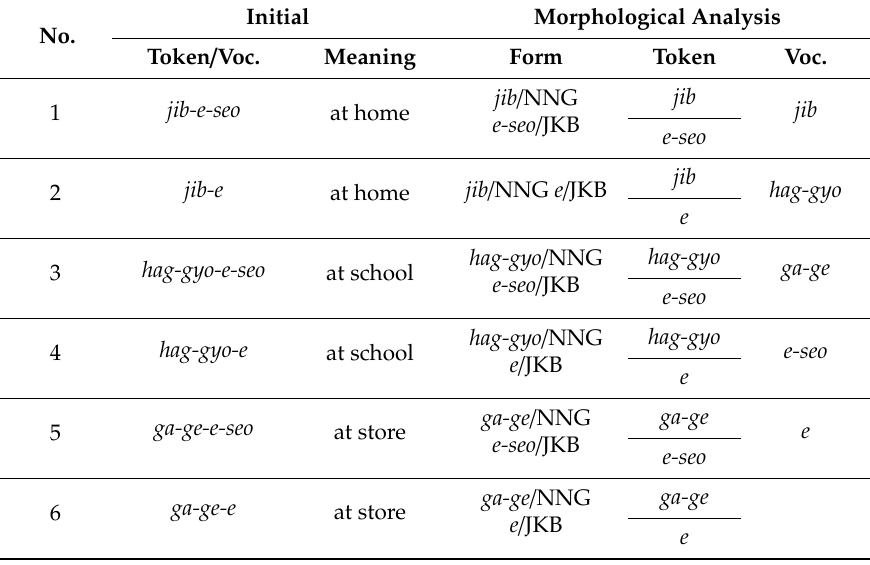
Table 9. The variation in the number of tokens and vocabulary in UPC after a morphological analysis. Voc. = vocabulary.